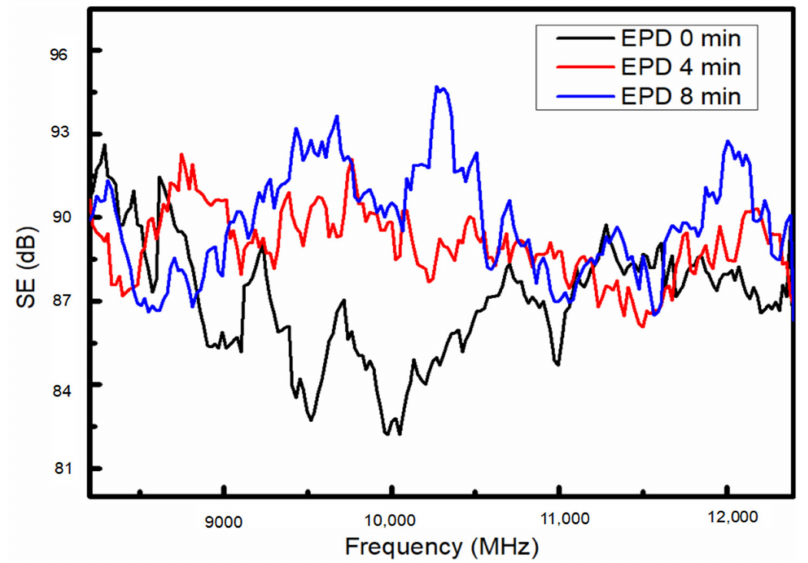
Figure 9. EMI shielding effectiveness of the different EPD time during 8.2–12.4